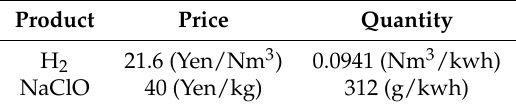
Table 5. Price and amount of electrolysis plant outputs.